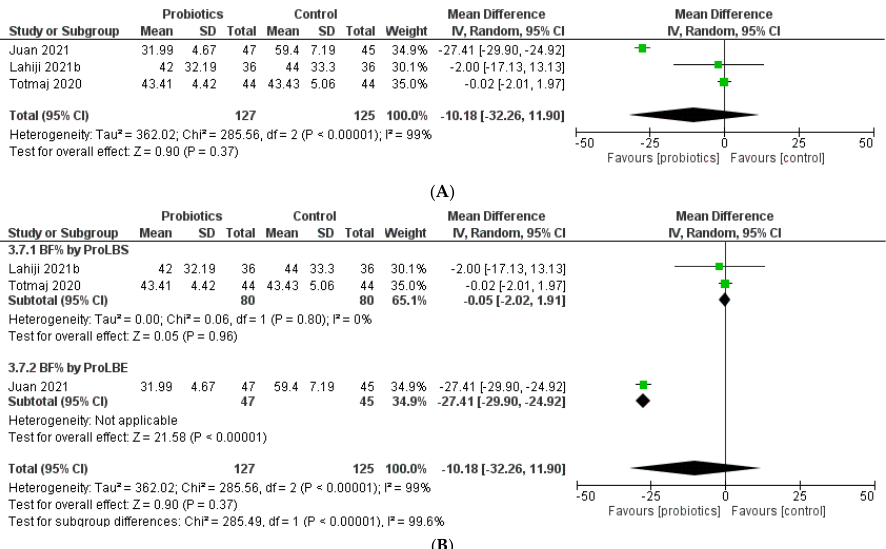
Figure 4. Meta-analysis for ( A ) percentage change in body fat (BF%) percent and ( B ) BF% by probi- otic type.